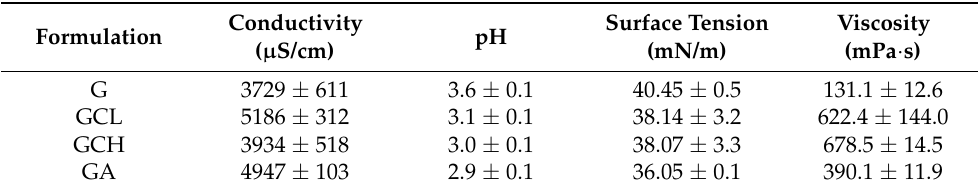
Table 2. Conductivity, pH, surface tension and viscosity values at 1000 s − 1 of the blends (mean values ± sd; n = 3).